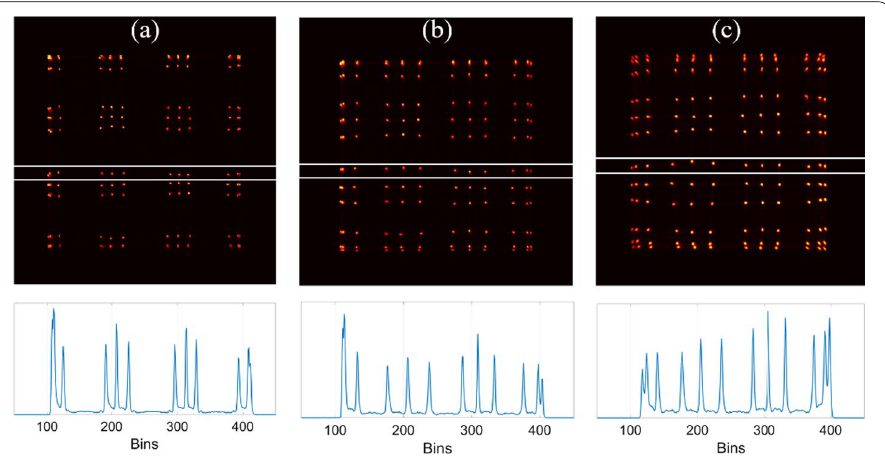
Fig. 5 (Top) Flood histograms and (bottom) line profiles of the middle row of the crystals of detector 3 using 12 12 LYSO crystals of 1.95 1.95 20 mm 3 measured a without a light guide, b with a 1-mm-thick glass × × × light guide, and c with a 1-mm-thick light guide with